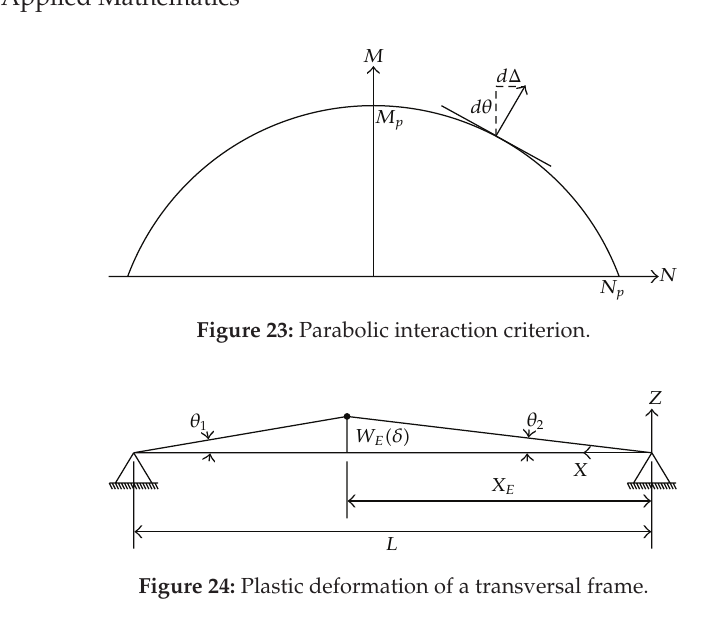
Figure 24: Plastic deformation of a transversal